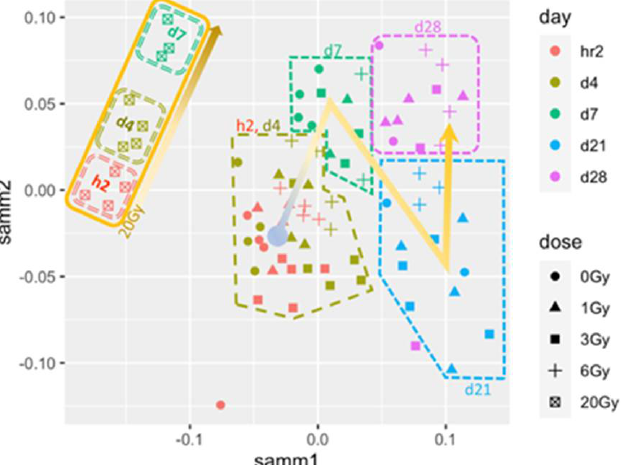
Figure 2. Sammon plot analysis showing separation of samples based on irradiation levels and time after exposure using transcriptomics.